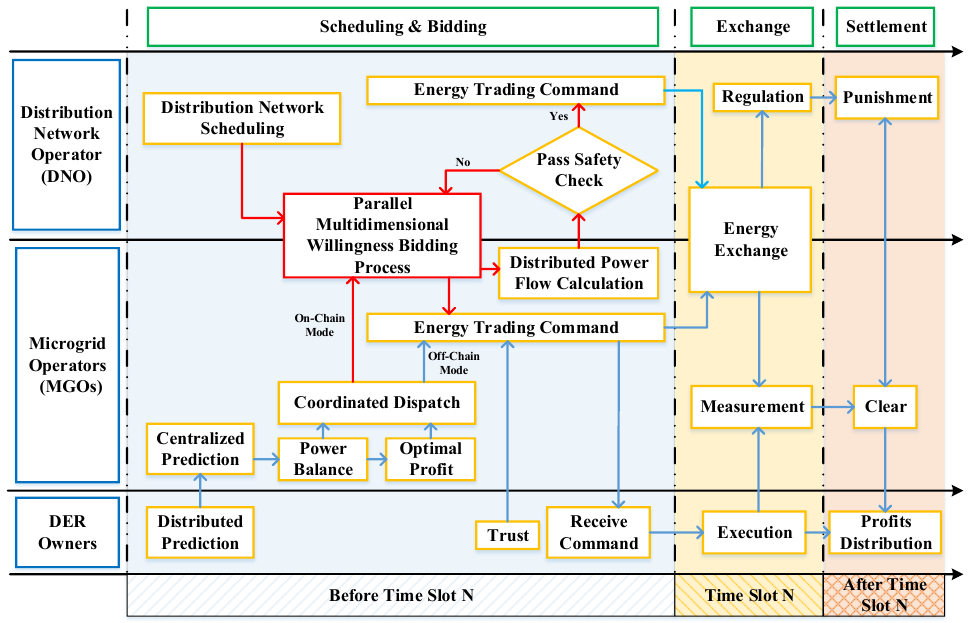
Figure 2. The process of the proposed P2P energy trading